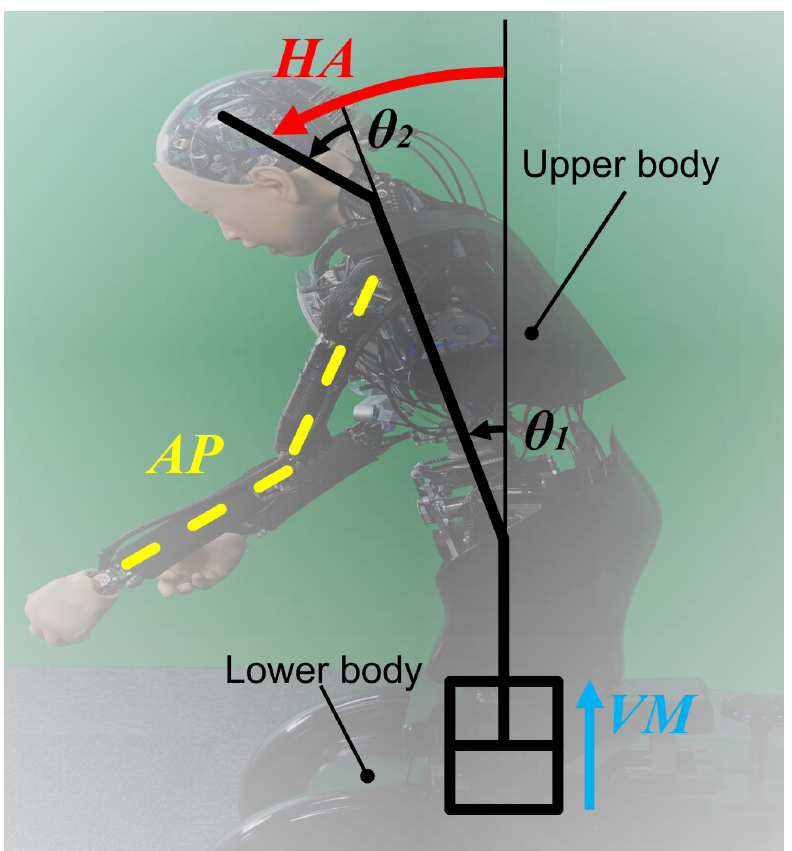
Fig 2. The body expression with the ambiguous facial expression and the configuration of HA, AP, and VM.